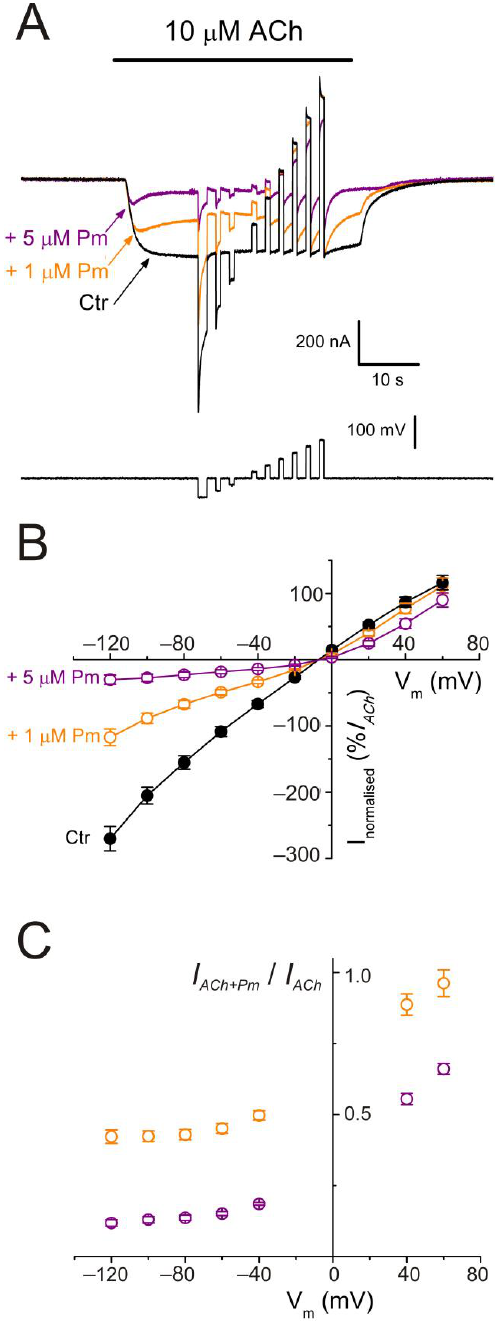
Fig.5 Figure 5. nAChR blockade by Pm is voltage-dependent. ( A ) I µ M ACh alone ACh s evoked by 10 (black recording) or in the presence of either 1 (orange) or 5 µ M (purple) Pm when applying voltage pulses from − 120 to +60 mV, as illustrated underneath. ( B ) Net i/v relationship of I ACh s elicited by the protocol shown in ( A ). Black symbols are for control I ACh s, whereas those evoked in the presence of Pm are drawn in either orange (+1 µ M Pm) or purple (+5 µ M Pm). Net I ACh s were normalized as the percentage of their control I ACh at − 60 mV ( n = 5–11; N = 2–3). ( C ) Plot displaying the I ACh remnant after co-application of either 1 (orange) or 5 µ M (purple) Pm ( I ACh+Pm ), normalized to their control ( I ACh ), versus the membrane potential (same cells as in ( B )). Notice that 1 µ M Pm, in contrast to 5 µ M, did not significantly decrease I ACh at +60